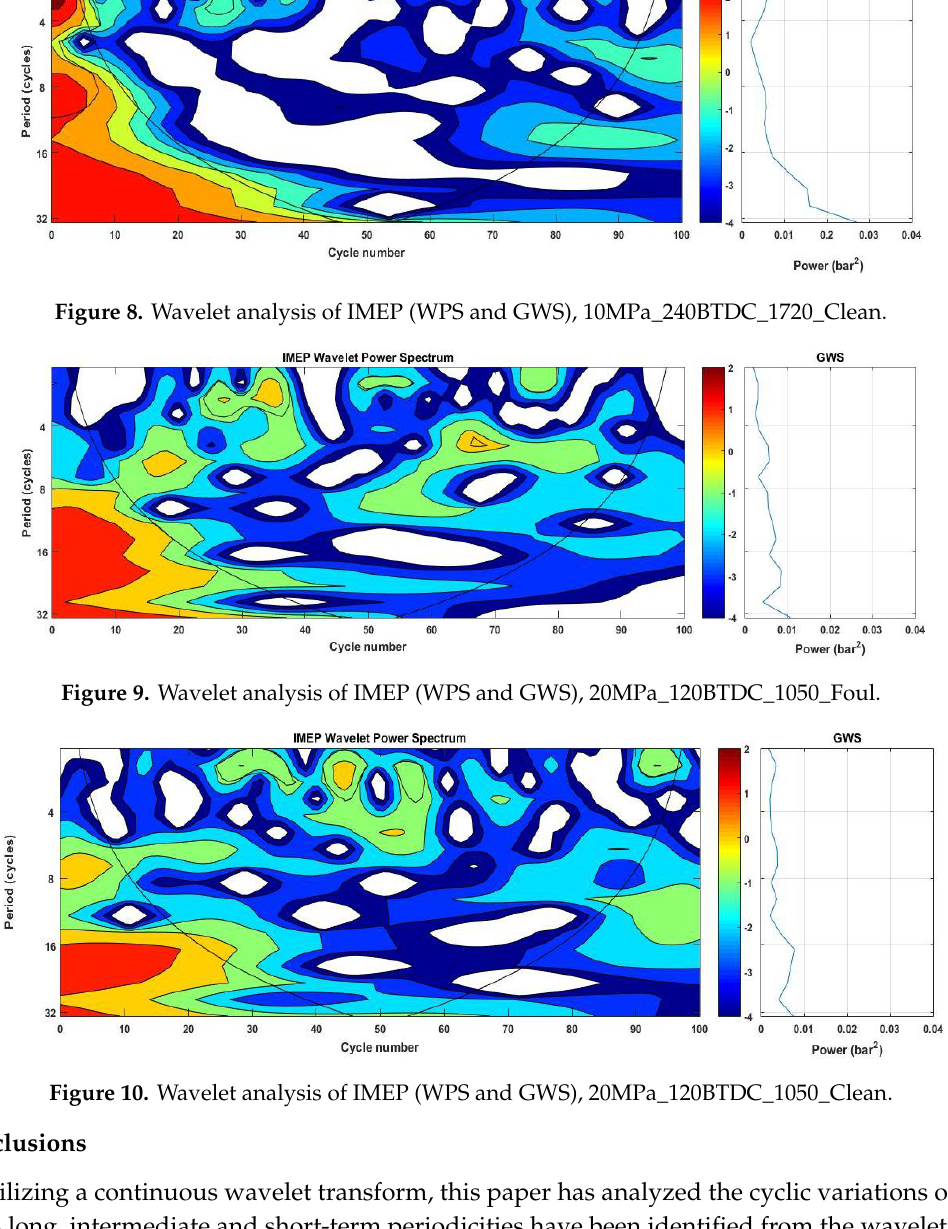
Figure 7. Wavelet analysis of IMEP (WPS and GWS), 10MPa_240BTDC_1800_Foul.